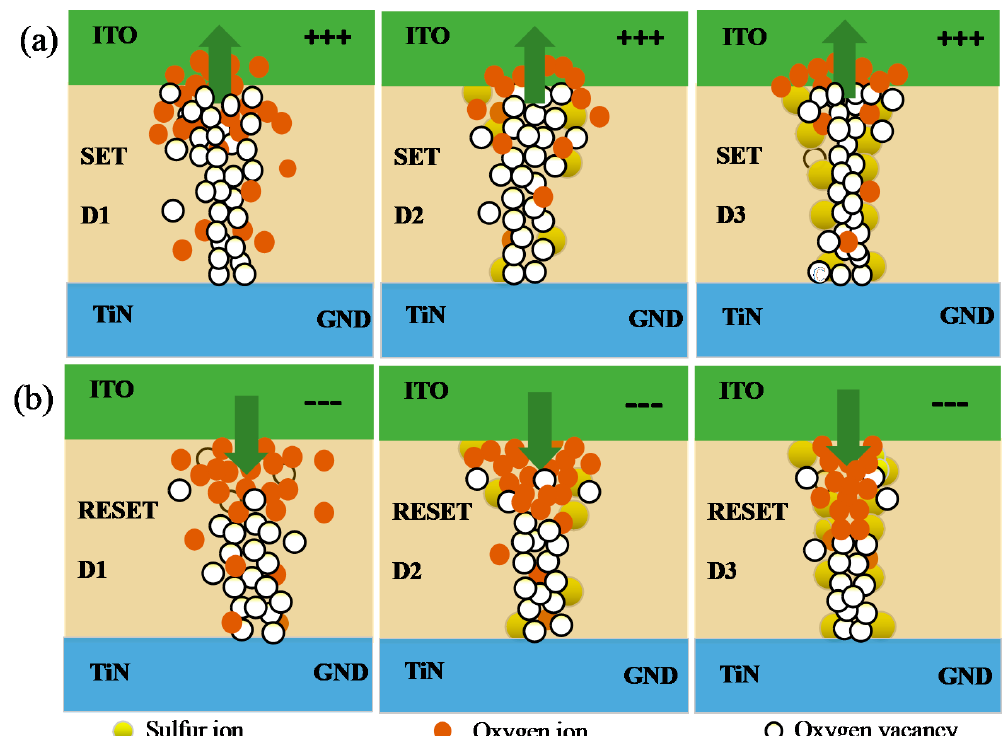
Figure 9. Schematic diagram of the switching mechanism of SET process for ( a ) D1, D2, and D3 and the RESET process for ( b ) D1, D2, and D3. (The green arrow represents the movement direction of oxygen ions, and the green box is the top electrode ITO of the device, and the blue box is the bottom electrode GND).